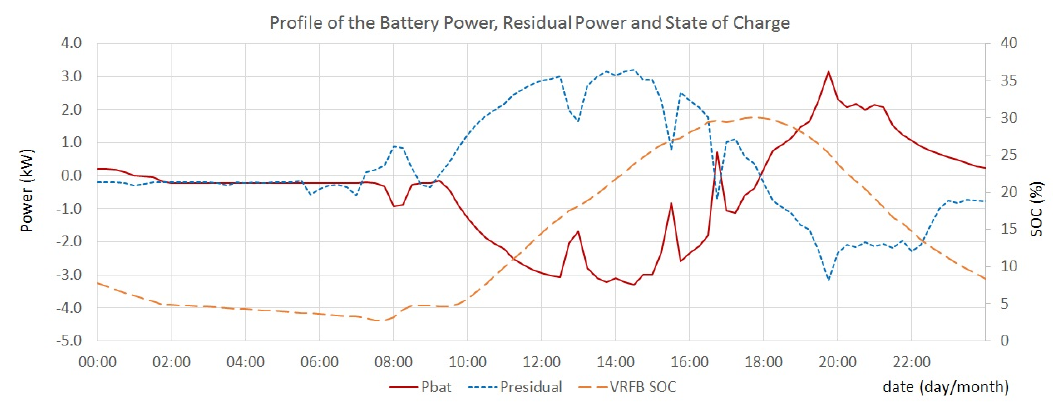
Figure 11. First day of the self-consumption maximization test.